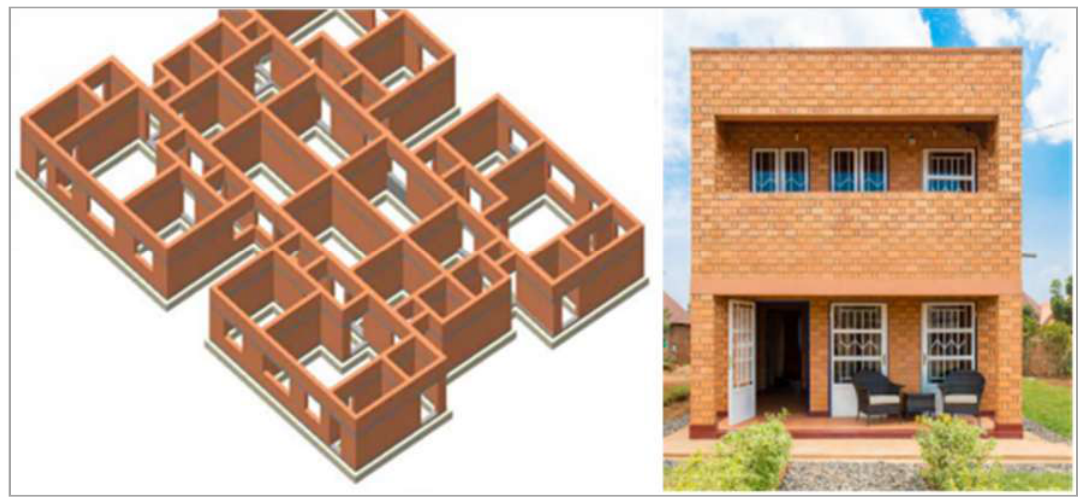
Figure 2. Modern Brick Duplex and model houses proposed by Skat. Data source: Skat Consulting Rwanda Ltd [93].